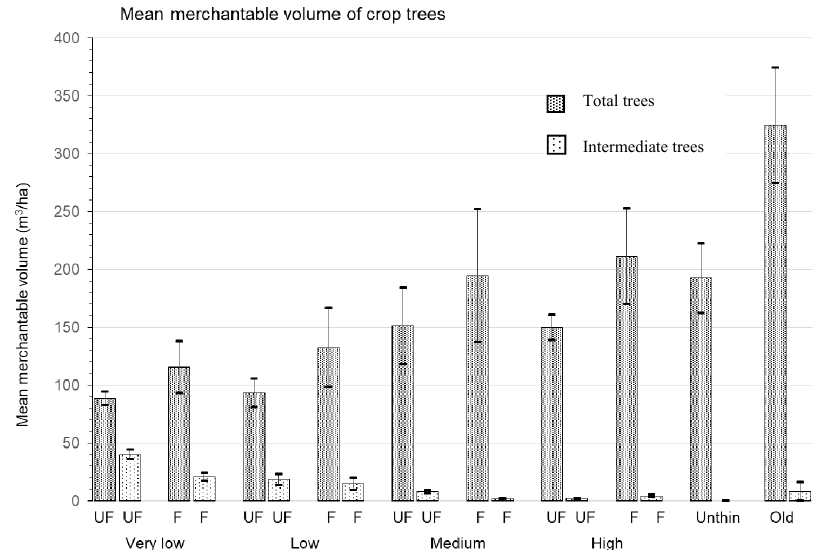
Figure 6. Mean ( n = 2, 3 replicate study areas; ± SE) merchantable volume (m 3 /ha) of total crop trees and intermediate (ingress) crop trees in the very low-, low-, medium-, and high-density stands of lodgepole pine with (F) and without (UF) fertilization, and in unthinned (Unthin) and old-growth (Old G) stands, 25 years after initiation of treatments.